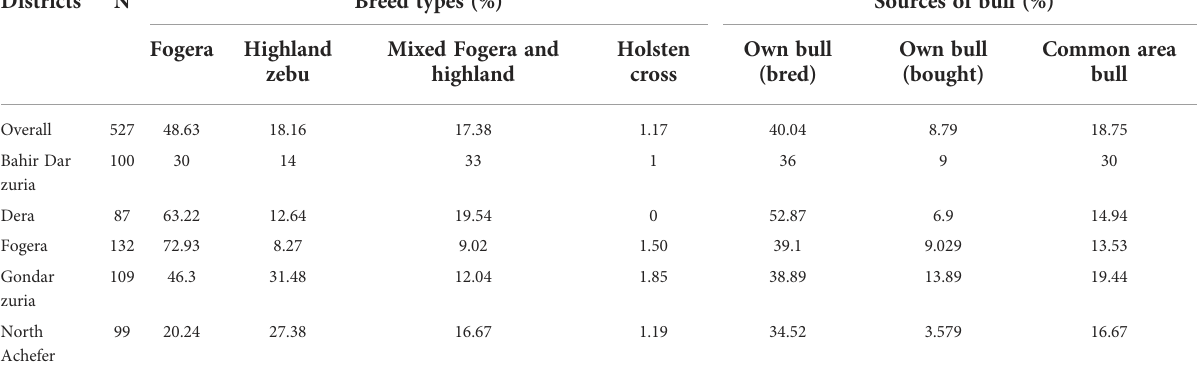
TABLE 8 Breed types for mating and sources of breeding bull. Districts